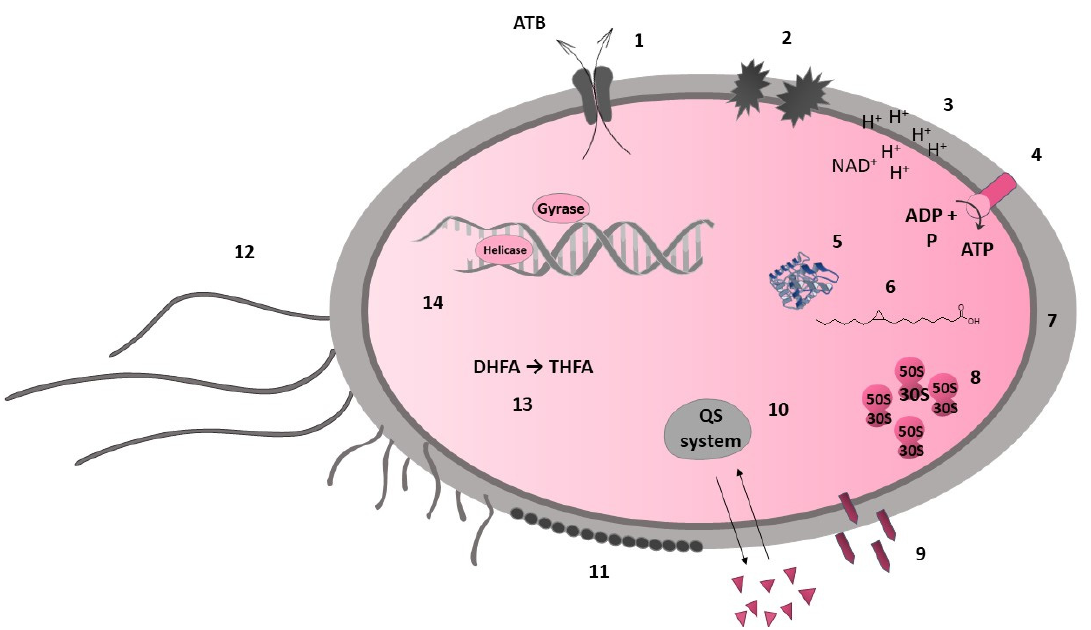
Figure 1. Bacterial targets of flavonoids. Cell membrane: efflux pump (1), membrane disruption (2), electron transport chain (3), ATP synthesis (4); bacterial metalloenzymes (5); fatty acid synthesis (FabG, FabZ, FabI) (6); cell wall synthesis (7): peptidoglycan, D-alanine–D-alanine ligase; protein synthesis (8): (cell envelope); nonspecific mechanism: bacterial toxic virulence factors (9), quorum sensing system (10), biofilm formation (disruption) (11), motility (12); folic acid metabolism: dihy- drofolate reductase (13); nucleic acid synthesis (14): DNA gyrase, topoisomerases I and IV, helicase, DNA intercalation.